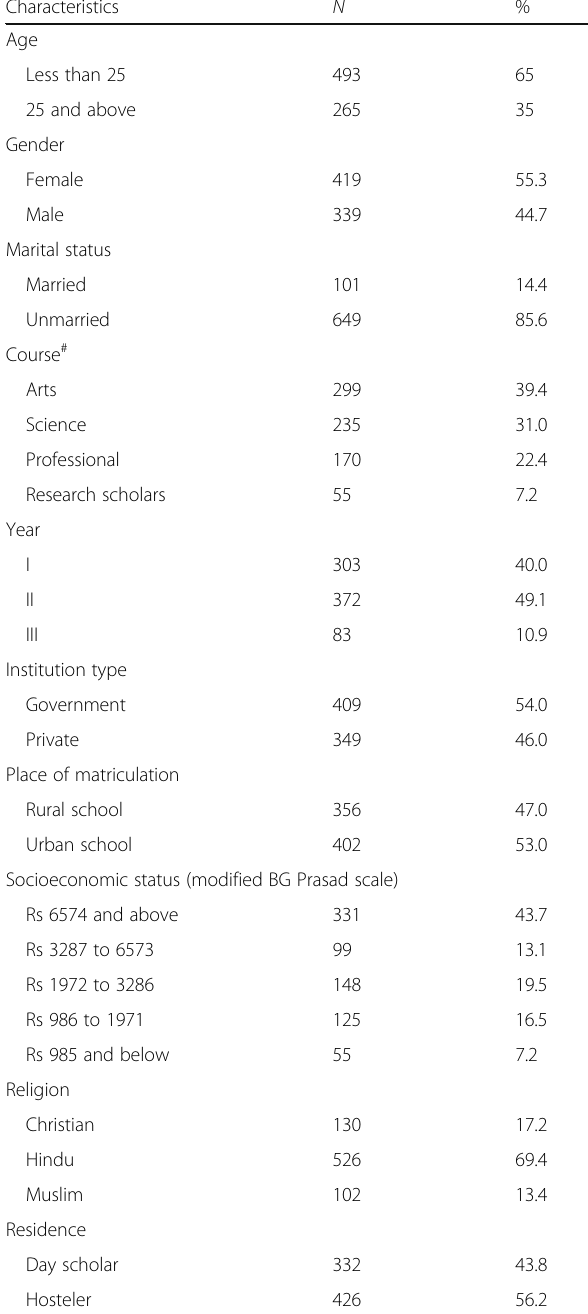
Table 1 Socio-demographic characteristics of the